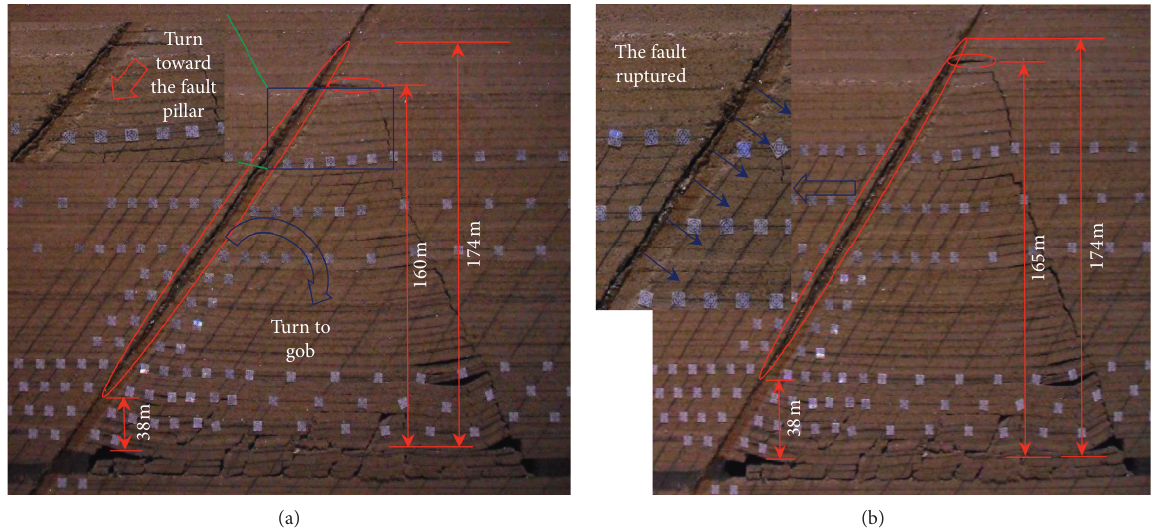
Figure 7: Overburden structure when the working face is 20m or 10m away from the fault. (a) Distance from the fault, 20m. (b) Distance from the fault,